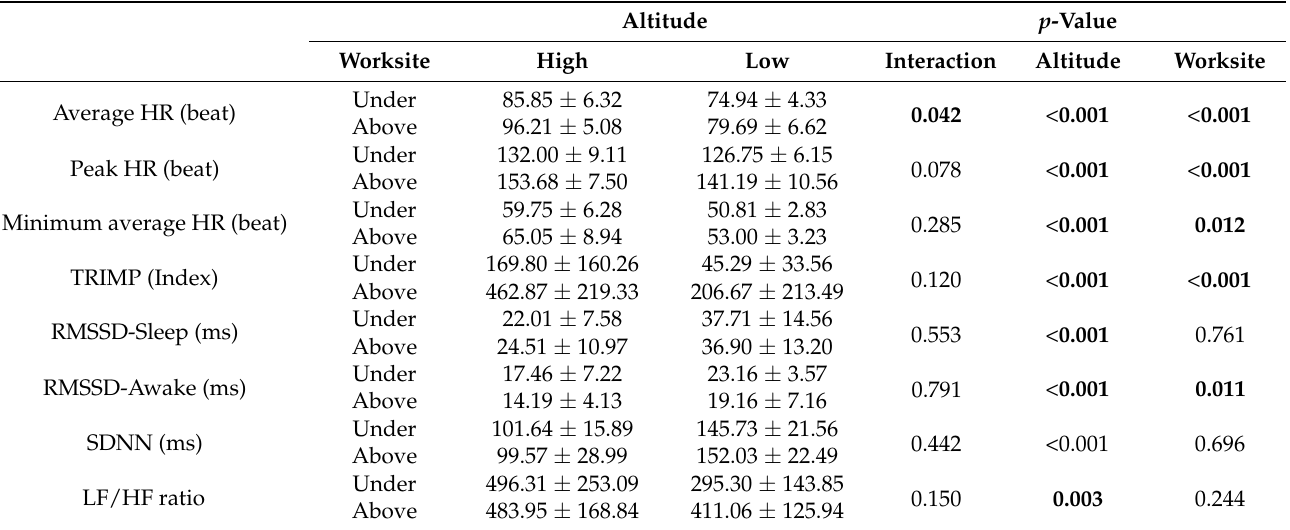
Table 2. Heart rate (HR) variables. Altitude p -Value Worksite